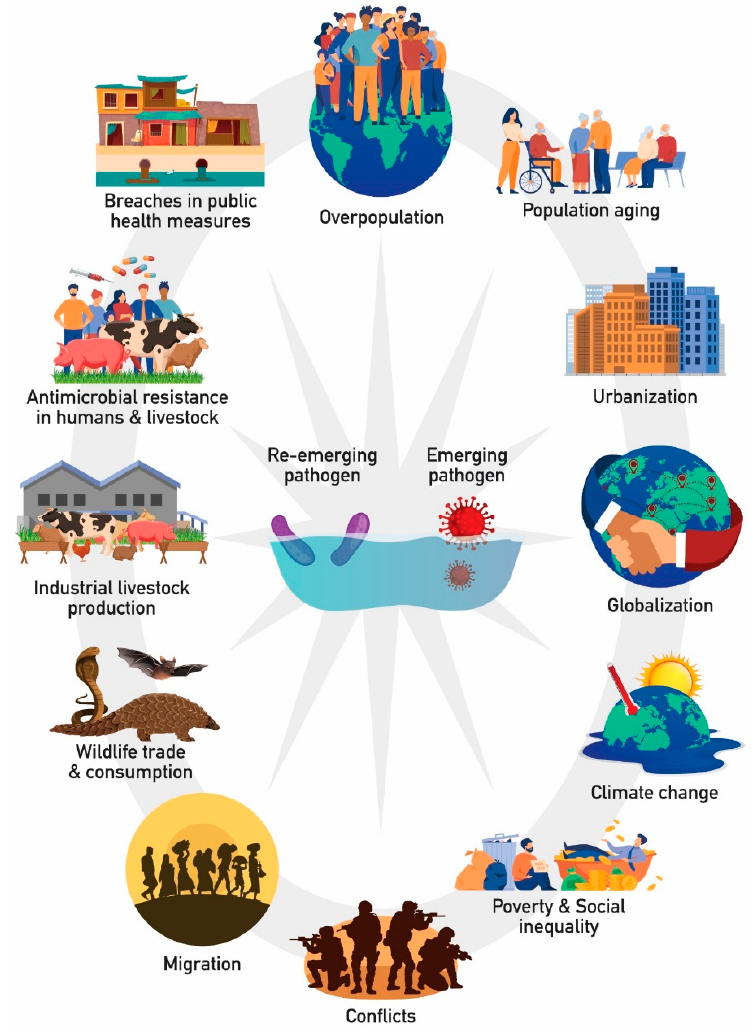
Figure 1. Factors that precipitate the occurrence and transmission of EIDs and REIDs.